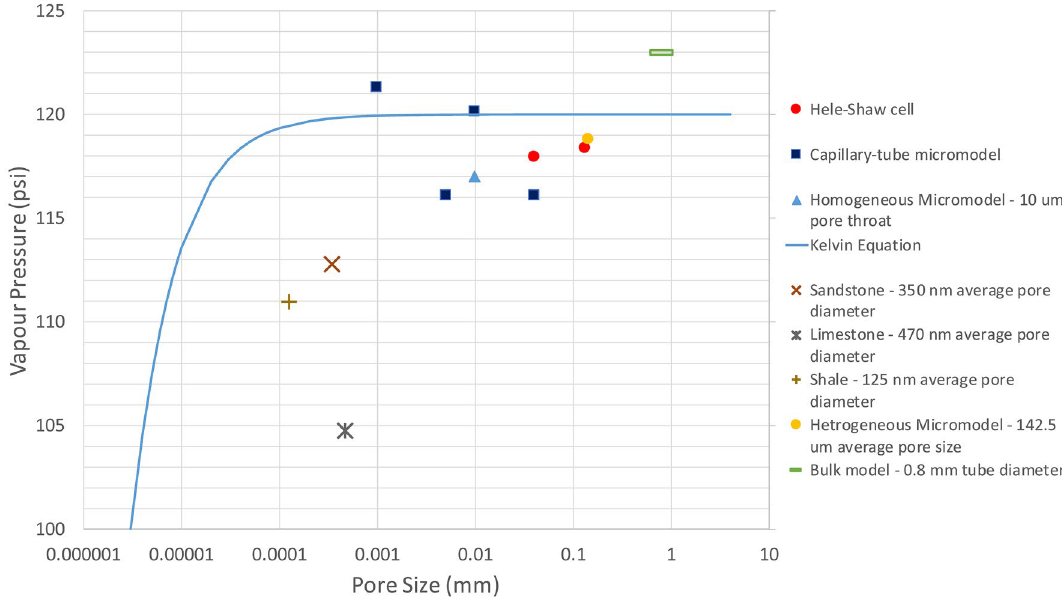
Figure 13. Measurement of propane vapour pressure in Hele–Shaw cells, micromodels, and rock samples. Each point for sandstone, limestone, and shale represents the average of 3 experiments (3 trials with 3 core samples from identical reservoir rock blocks). Each point for the bulk condition represents the average of 3 trials, and each point for the Hele–Shaw cell and microfluidic chip represents the average of 2 trials. All the pressure values in this figure were measured at 20 °C (293.15 K).